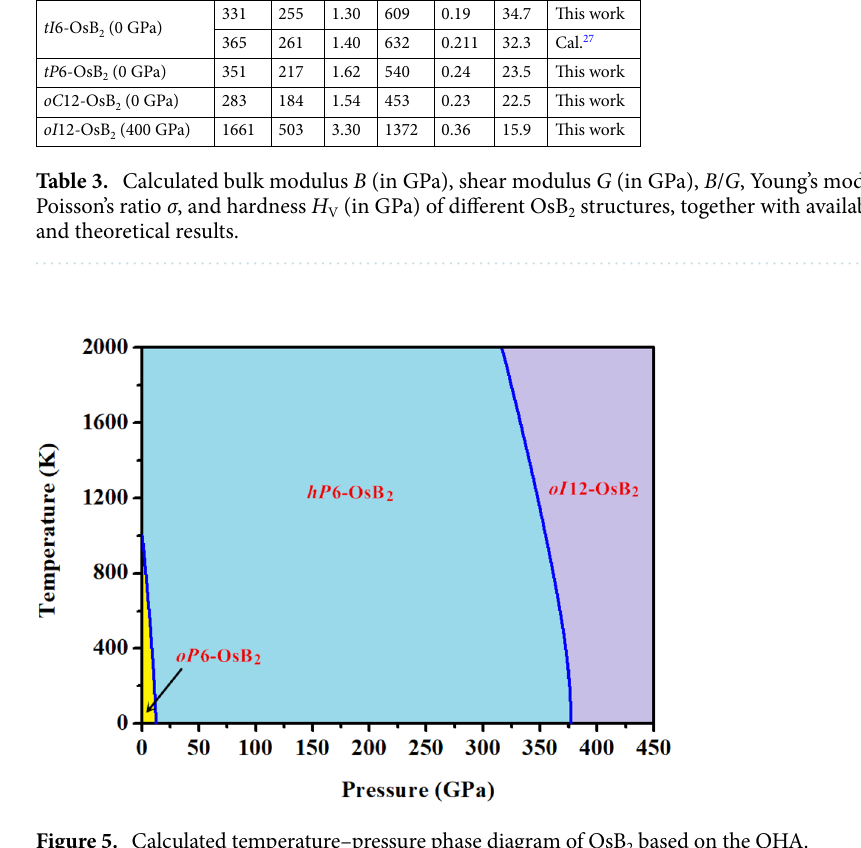
Figure 5. Calculated temperature–pressure phase diagram of OsB 2 based on the